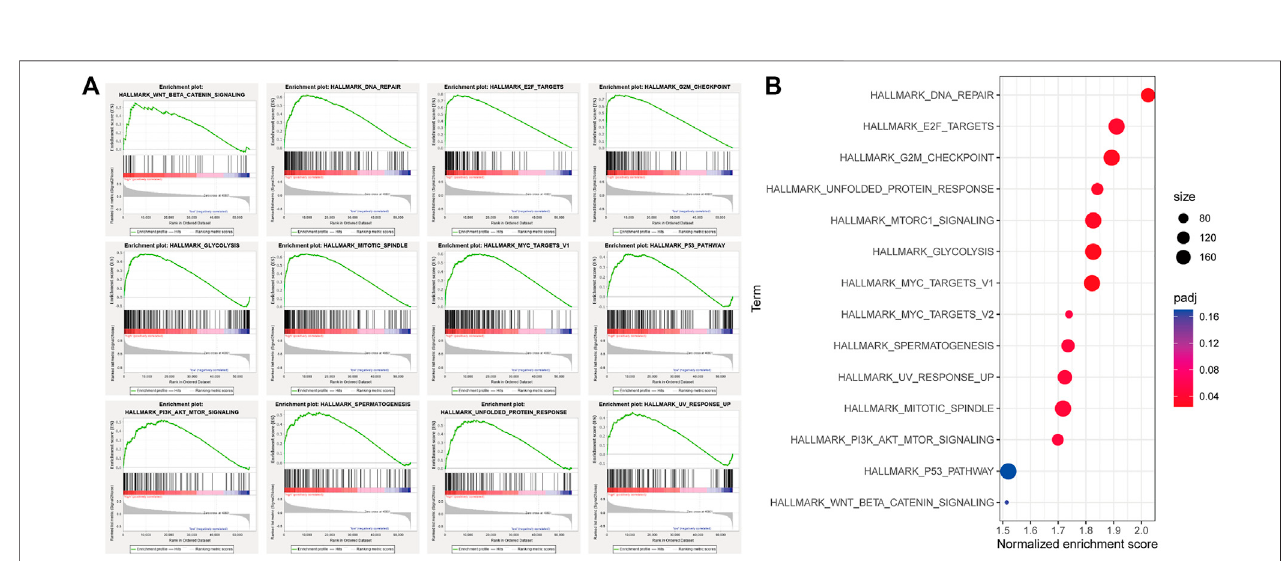
FIGURE 6 | Gene set enrichment analysis (GSEA) between high and low autophagy risk groups. (A) , Twelve cancer hallmark gene sets are enriched in the high autophagy risk group in patients with HCC ( p < 0.05, FDR < 0.25, |NES| > 1). (B) bubble chart for visualizing the GSEA result.